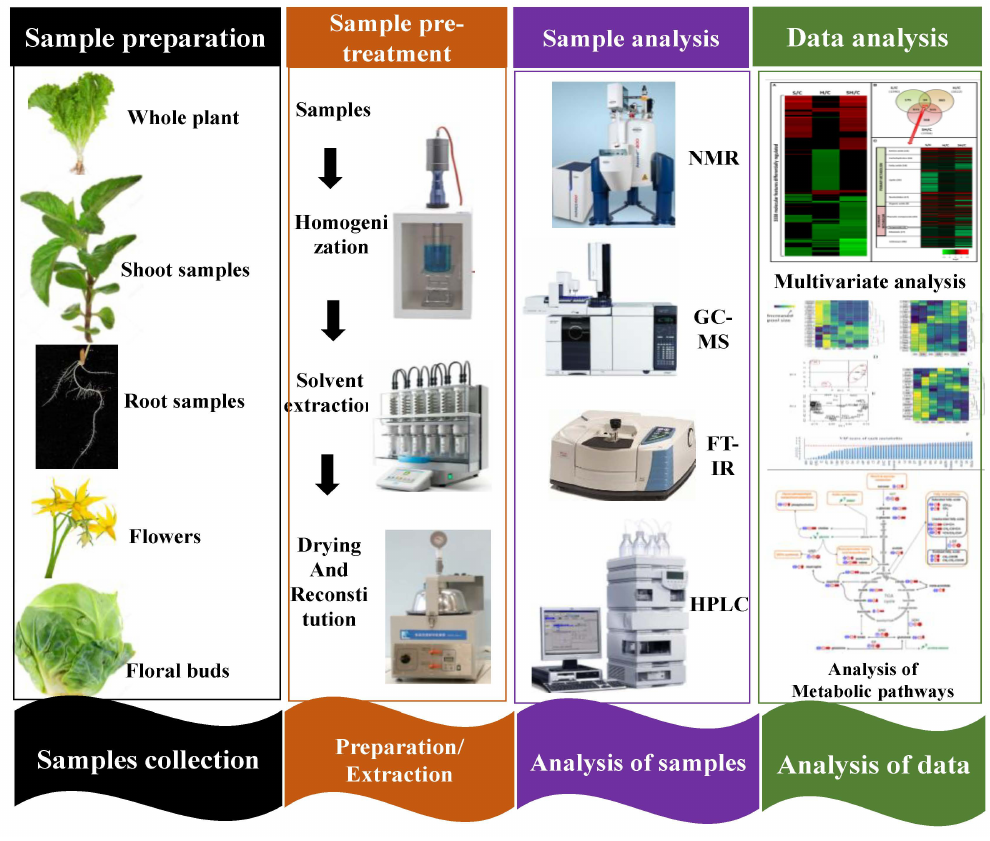
Figure 2. The overall scheme of biological sample analysis using metabolomic tools. Table 1. Examples of some extraction methods for metabolomic analysis of